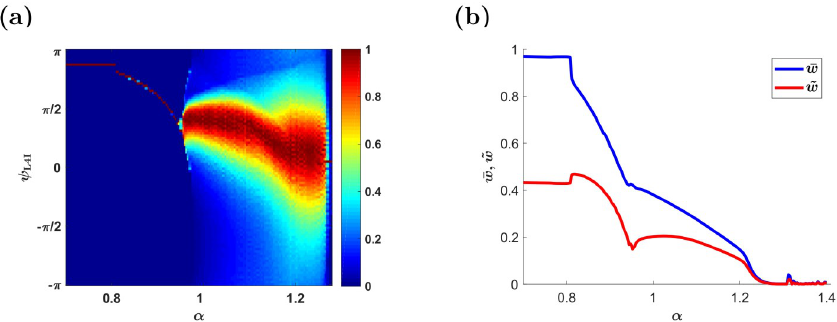
Fig 10. The effect of the relative strength of depression, α . (a) The mean input phase κ L4I as a function of α . Probability of occurrences is depicted by color as shown in the right color bar. (b) The order parameters � w and ~ w are shown as a function of α . Here, we used: κ VPM = 1, ψ 0 = 5 π /6, γ = 1, D = 10hz, and d = 3ms. The temporally asymmetric STDP rule, Eq (9), was used with: τ = 50ms, τ + = 22ms, μ = 0.01 and λ = −